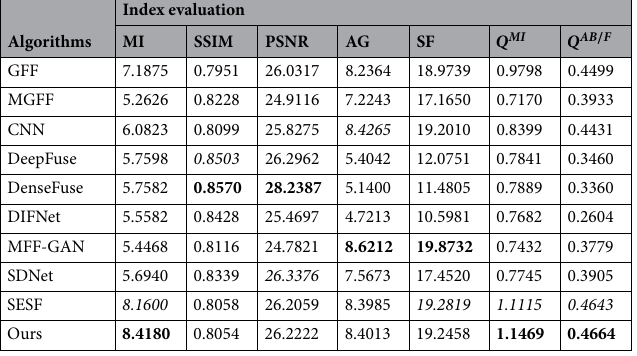
Table 1. Comparison of various algorithms. Bold is the best, italic is the second best.